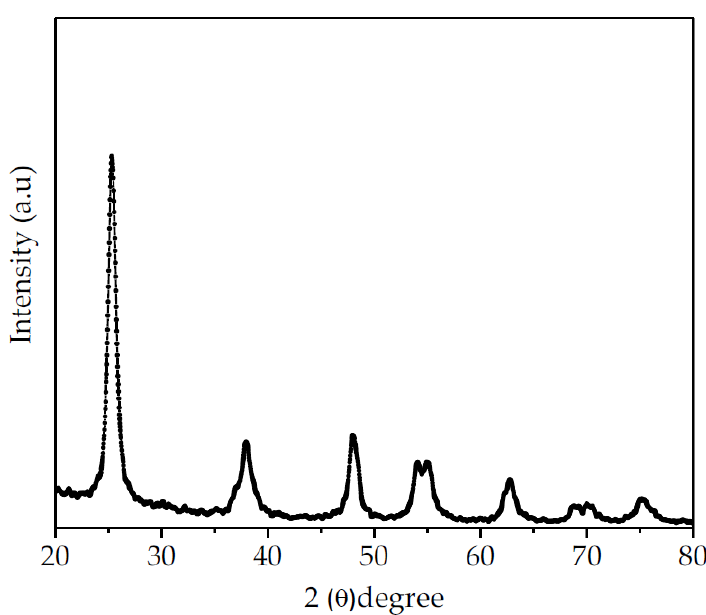
Figure 3. XRD patterns showing the anatase crystalline structure of the synthesized TiO 2